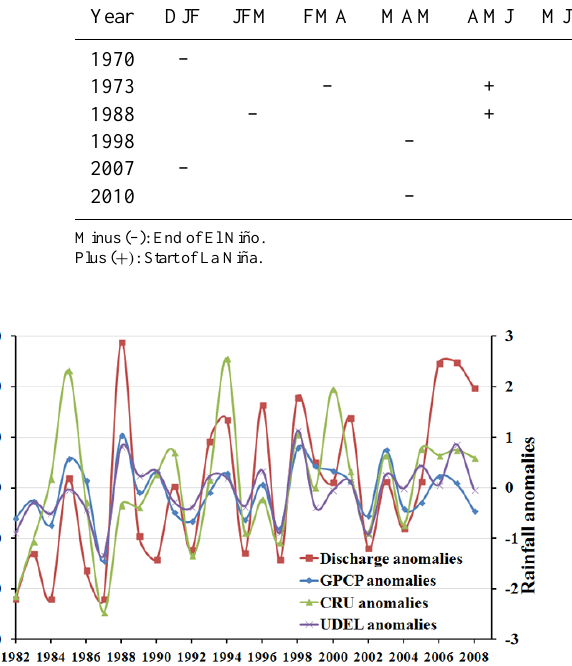
Fig. 8. Discharge anomalies at Eldiem station and GPCP, CRU and UDEL rainfall anomalies and over Ethiopian Highlands (35 ◦ E, 40 ◦ E, 8 ◦ N, 13 ◦ N) during JJAS from 1982 to 2008.